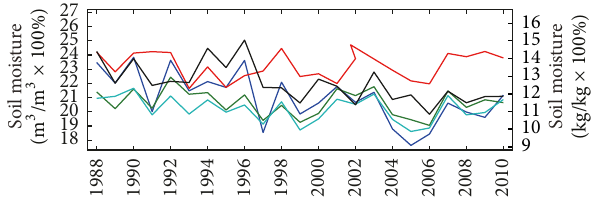
Table 1, the SM ECV data is highly correlated with the SM in situ shows an obvious downward trend with a rate of −